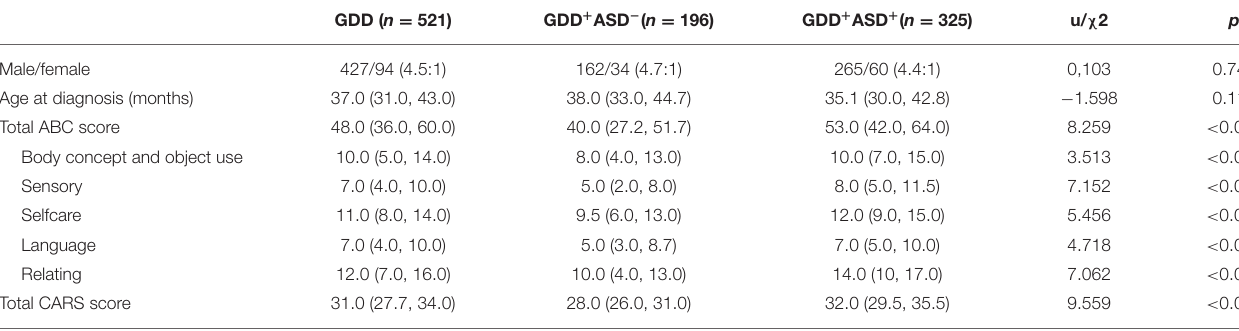
TABLE 1 | The characteristics of the study population.